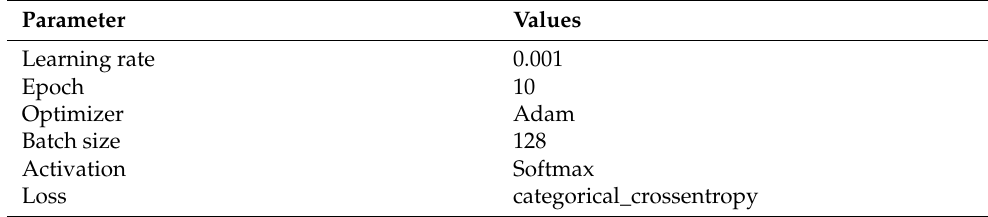
Table 3. Parameter setting of RNN.